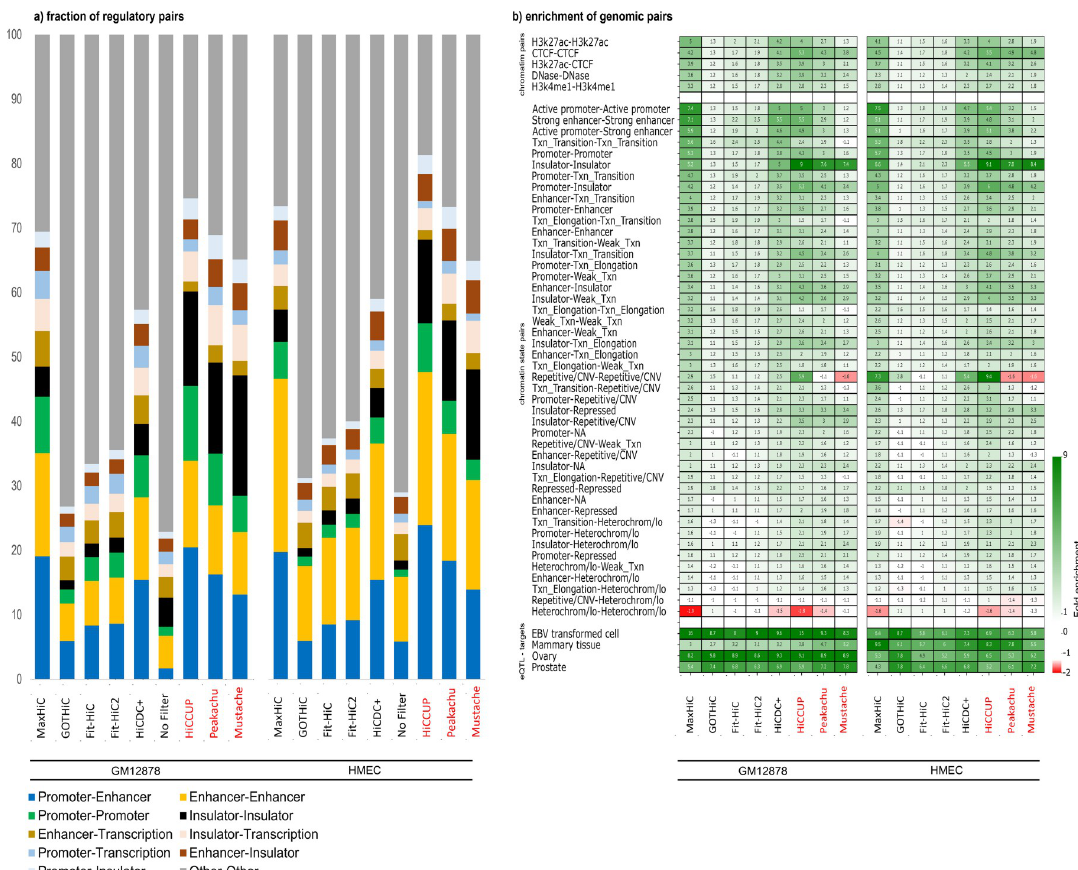
Fig 3. MaxHiC enriches for interactions between regulatory regions, eQTL-target pairs and known enhancer-promoter pairs. a) Fraction of regulatory elements in the significant interactions identified by the four models. b) Enrichment of cell line specific chromatin pairs, chromatin state pairs, and eQTL pairs that overlapped with both ends of the significant interactions identified by the six models at fragment size 10kb. The enrichment is calculated by dividing the fraction of features overlapping both ends of the significant interactions identified by each model by the fraction of features overlapping both ends of all interactions ( see methods